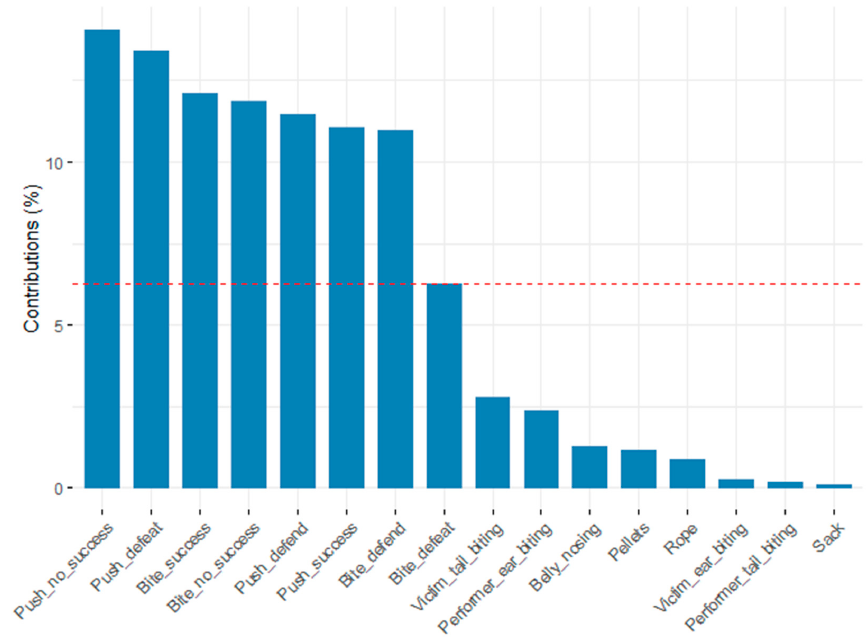
Figure 2. Contribution of variables to principal component factors 1 and 2 for all pigs; dashed line = expected value if contribution were uniform.